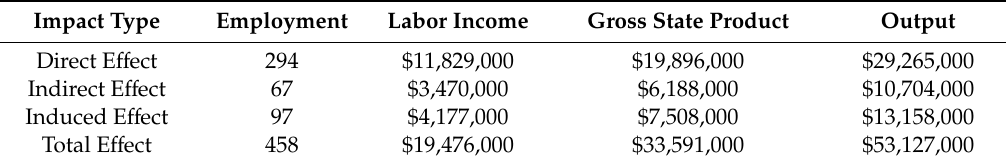
Table 4. Economic contribution of retail and associated wholesale